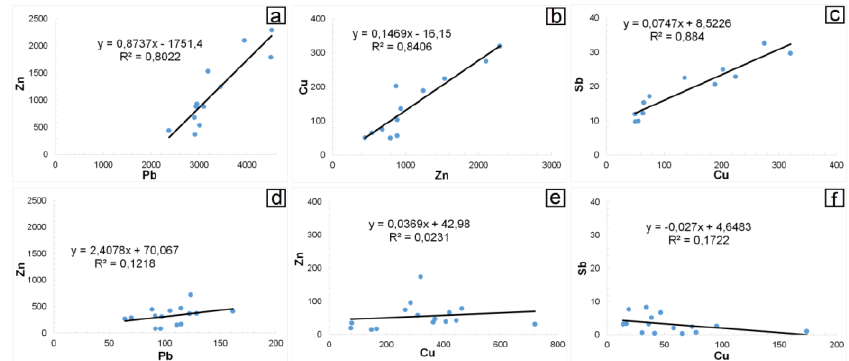
Figure 6. Correlation between the Zn vs. Pb, Cu vs. Zn e Sb vs. Cu of the two different sites: ( a , b , c ) Complex of San Domenico Maggiore ; ( d , e , f ) Cloister of San Marcellino e Festo.